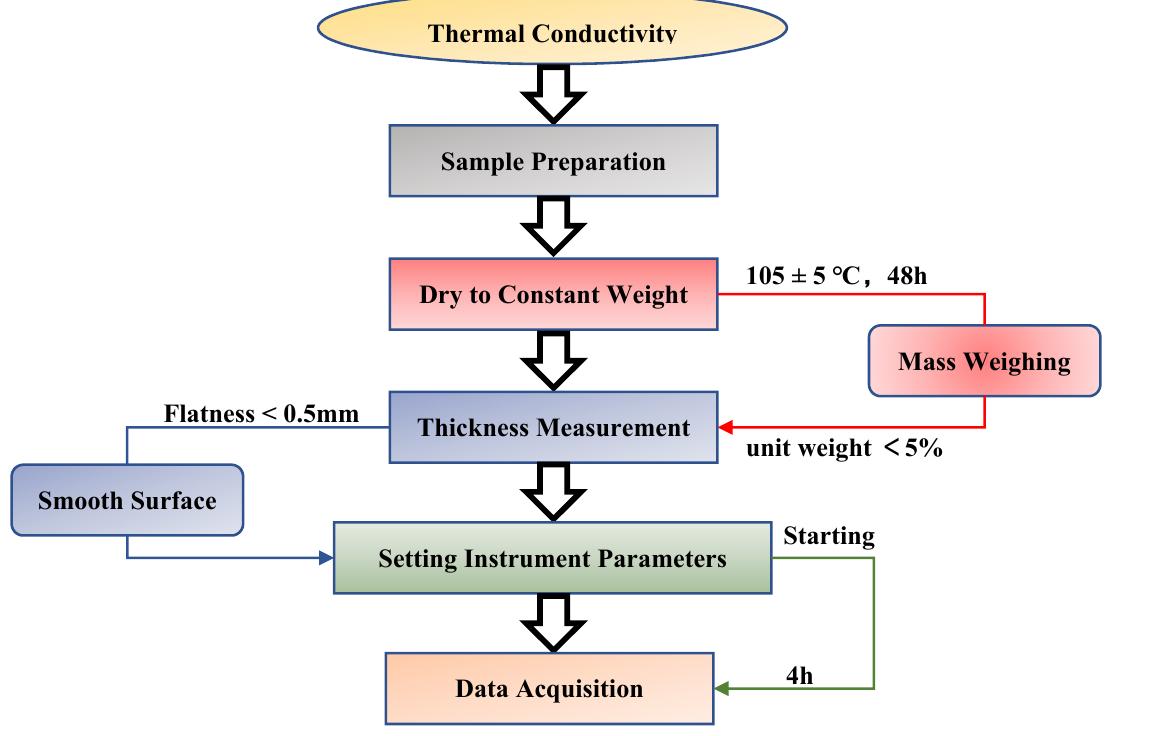
Figure 4. Measurement of thermal conductivity on the RTIC. Table 4. Mixing proportions of concrete mixtures (kg/m 3 ).